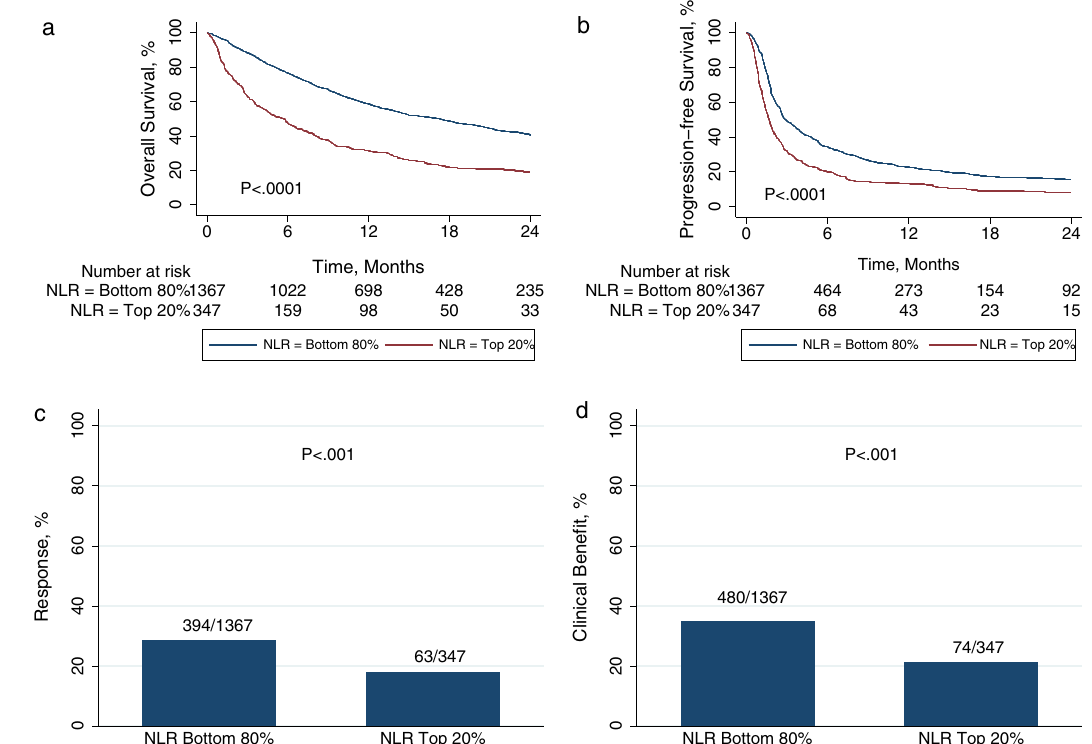
Fig. 1 Pan-cancer outcomes based on neutrophil-to-lymphocyte ratio (NLR). a Overall survival, b progression-free survival, c response, and d clinical bene fi t at a pan-cancer level based on high vs. low NLR. The cutoff was the top 20th percentile within each cancer type. P -values are according to log-rank test for a and b , and Pearson ’ s χ 2 -test for c and d